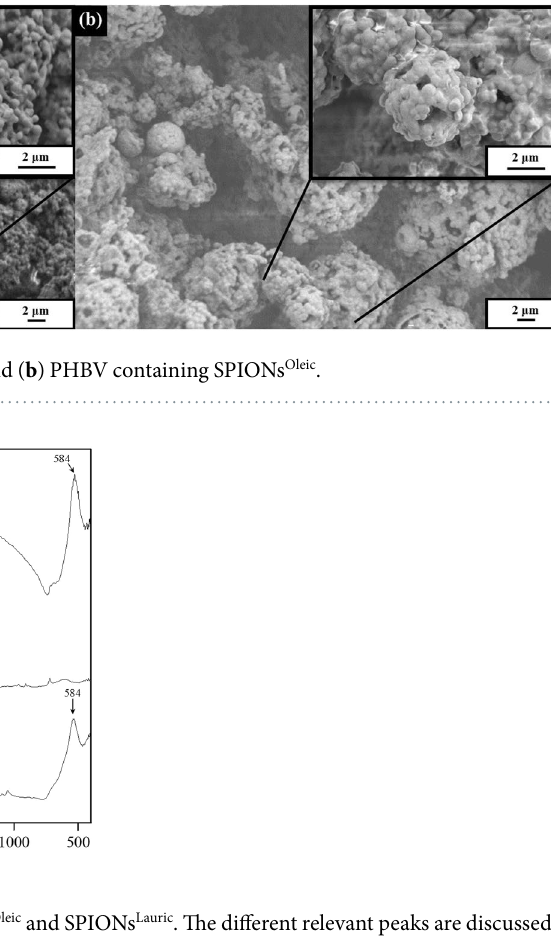
Figure 2. FTIR of uncoated SPIONs, SPIONs Oleic and SPIONs Lauric . The different relevant peaks are discussed in the